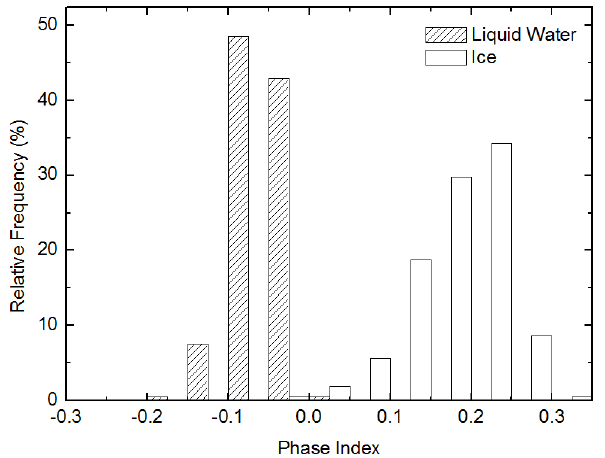
Fig. 4. Relative frequency of phase indices for ice and liquid water clouds ( r eff =15µm) for varied sensor viewing geometries based on 600 cases.